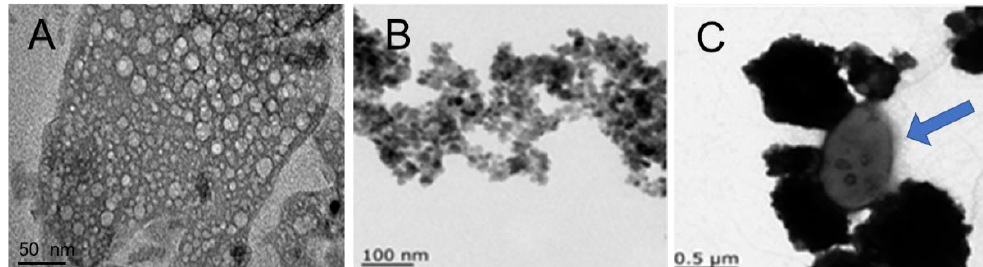
Figure 2. TEM of (A) Fe 3 O 4 @OA@DP, (B) Fe 3 O 4 @OA@DP-mannose, (C) Fe 3 O 4 @OA@DP – mannose – E. Figure 2. TEM of ( A ) Fe 3 O 4 @OA@DP, ( B ) Fe 3 O 4 @OA@DP-mannose, ( C ) Fe 3 O 4 @OA@DP–mannose– coli . The arrow indicates an immobilized E. coli cell. E. coli . The arrow indicates an immobilized E. coli